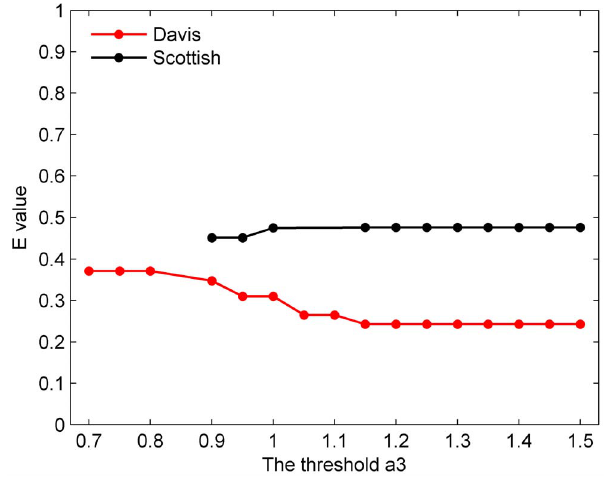
Figure 6. The relationship between a 3 and E value.